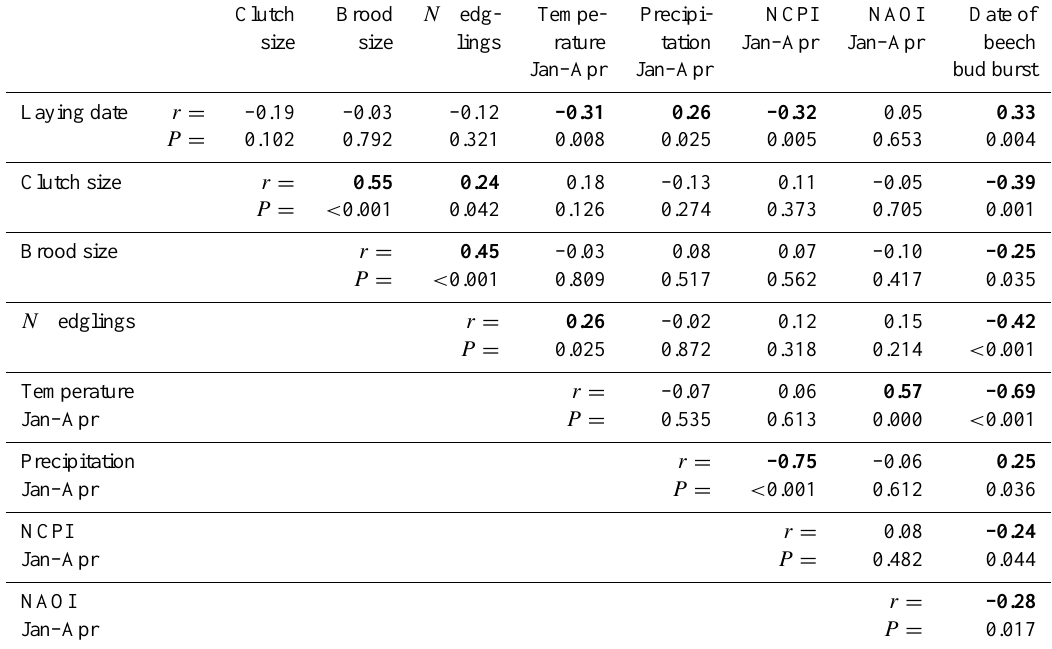
Table 2. Matrix of bivariate correlations (Pearson’s r ) of the variables included in the structural equation model (SEM). Clutch Brood N fledg- Tempe- Precipi- size size lings rature tation